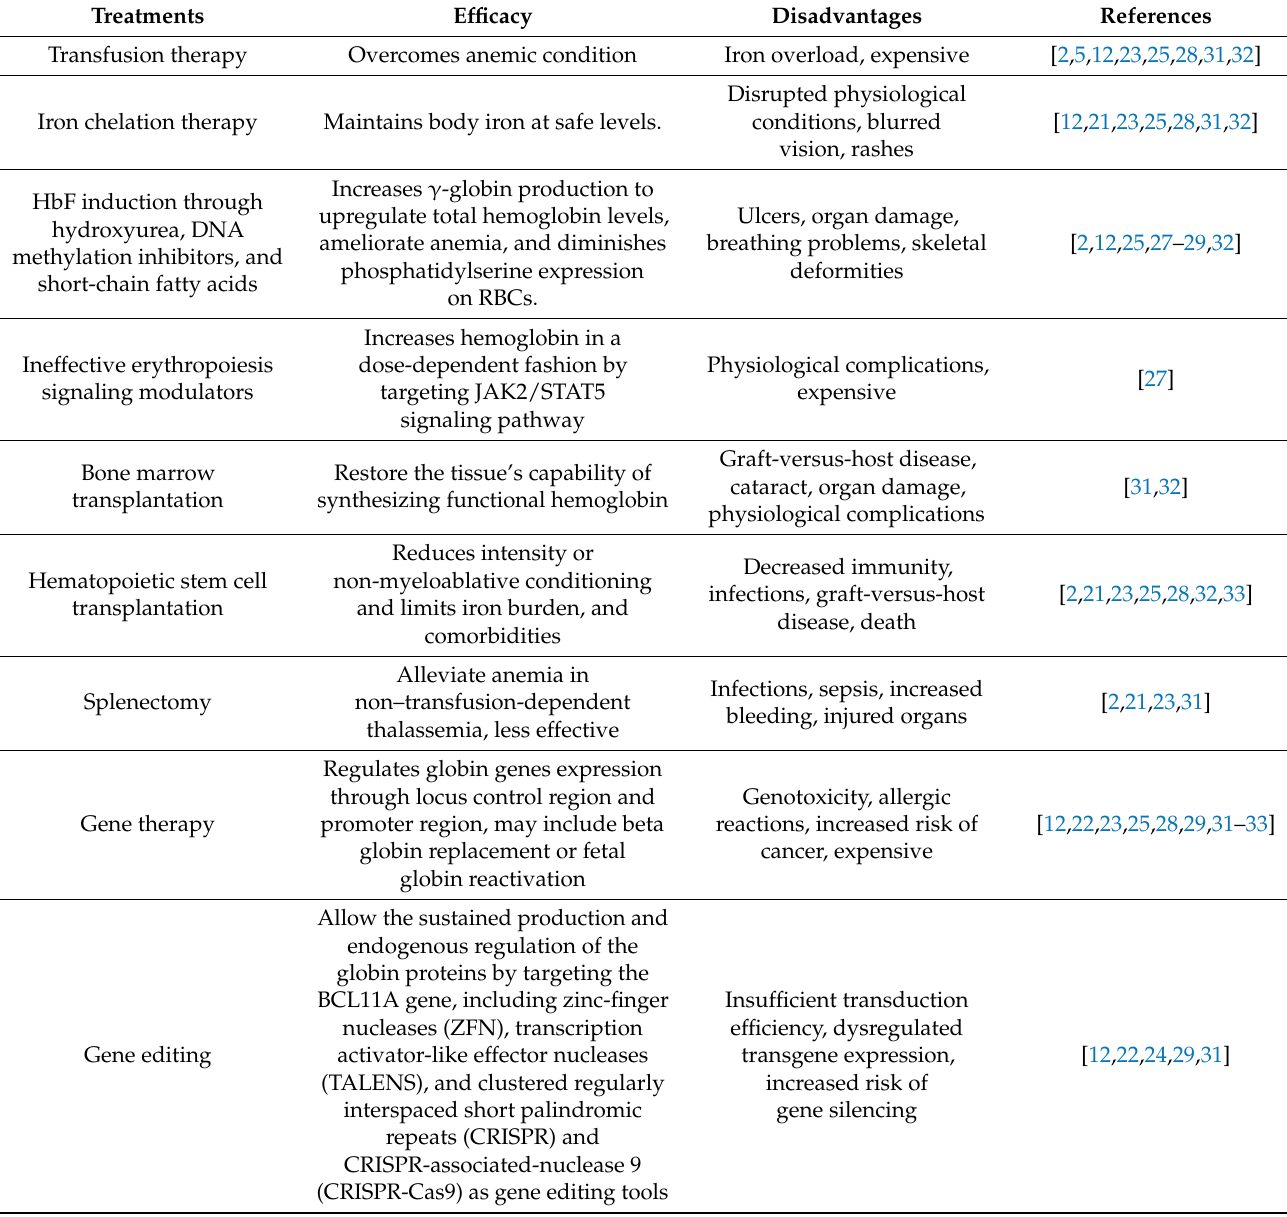
Table 1. The conventional therapeutic approaches in use along with their efficacy in the amelioration of the adverse symptoms and treatment of